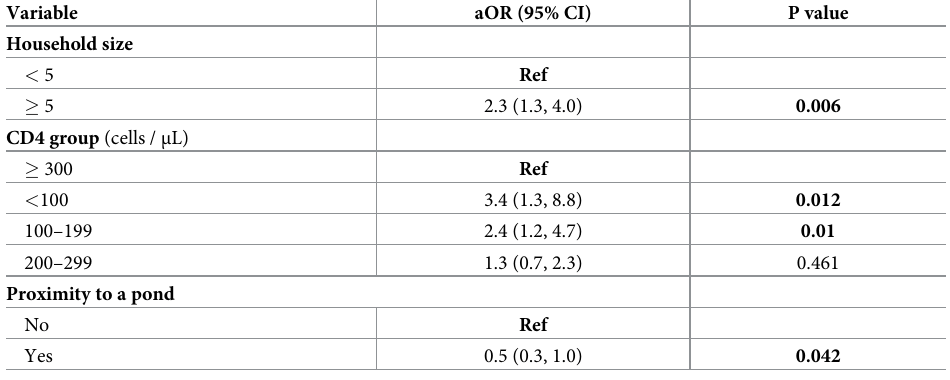
Table 5. Multivariable risk factor analysis for asymptomatic Leishmania infection (ALI) in 1,296 people living with HIV (PLHIV) in Bihar,